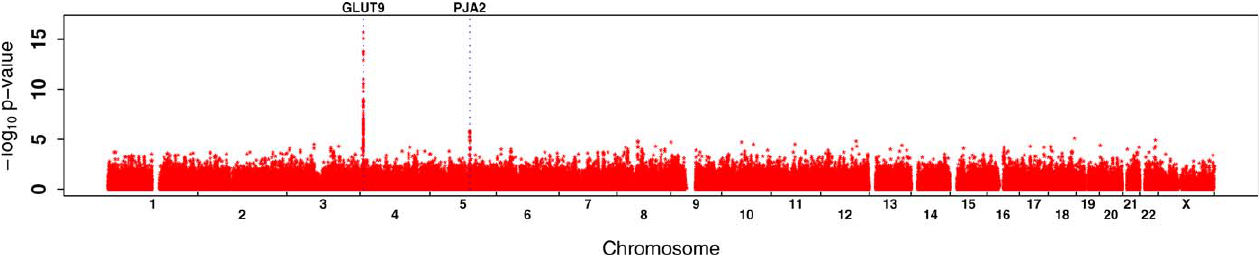
Figure 1. Genome-Wide Association Scan Results for UA Levels in Sardinian Cohort Probability of association (plotted as (cid:2) log 10 ) according to their positions along the p to q arms of each chromosome (1 to 22 and X) for each of 362,169 SNPs that passed quality control filters. The highest p -values are at the positions of the GLUT9 and PJA2 genes, and are indicated by vertical dotted